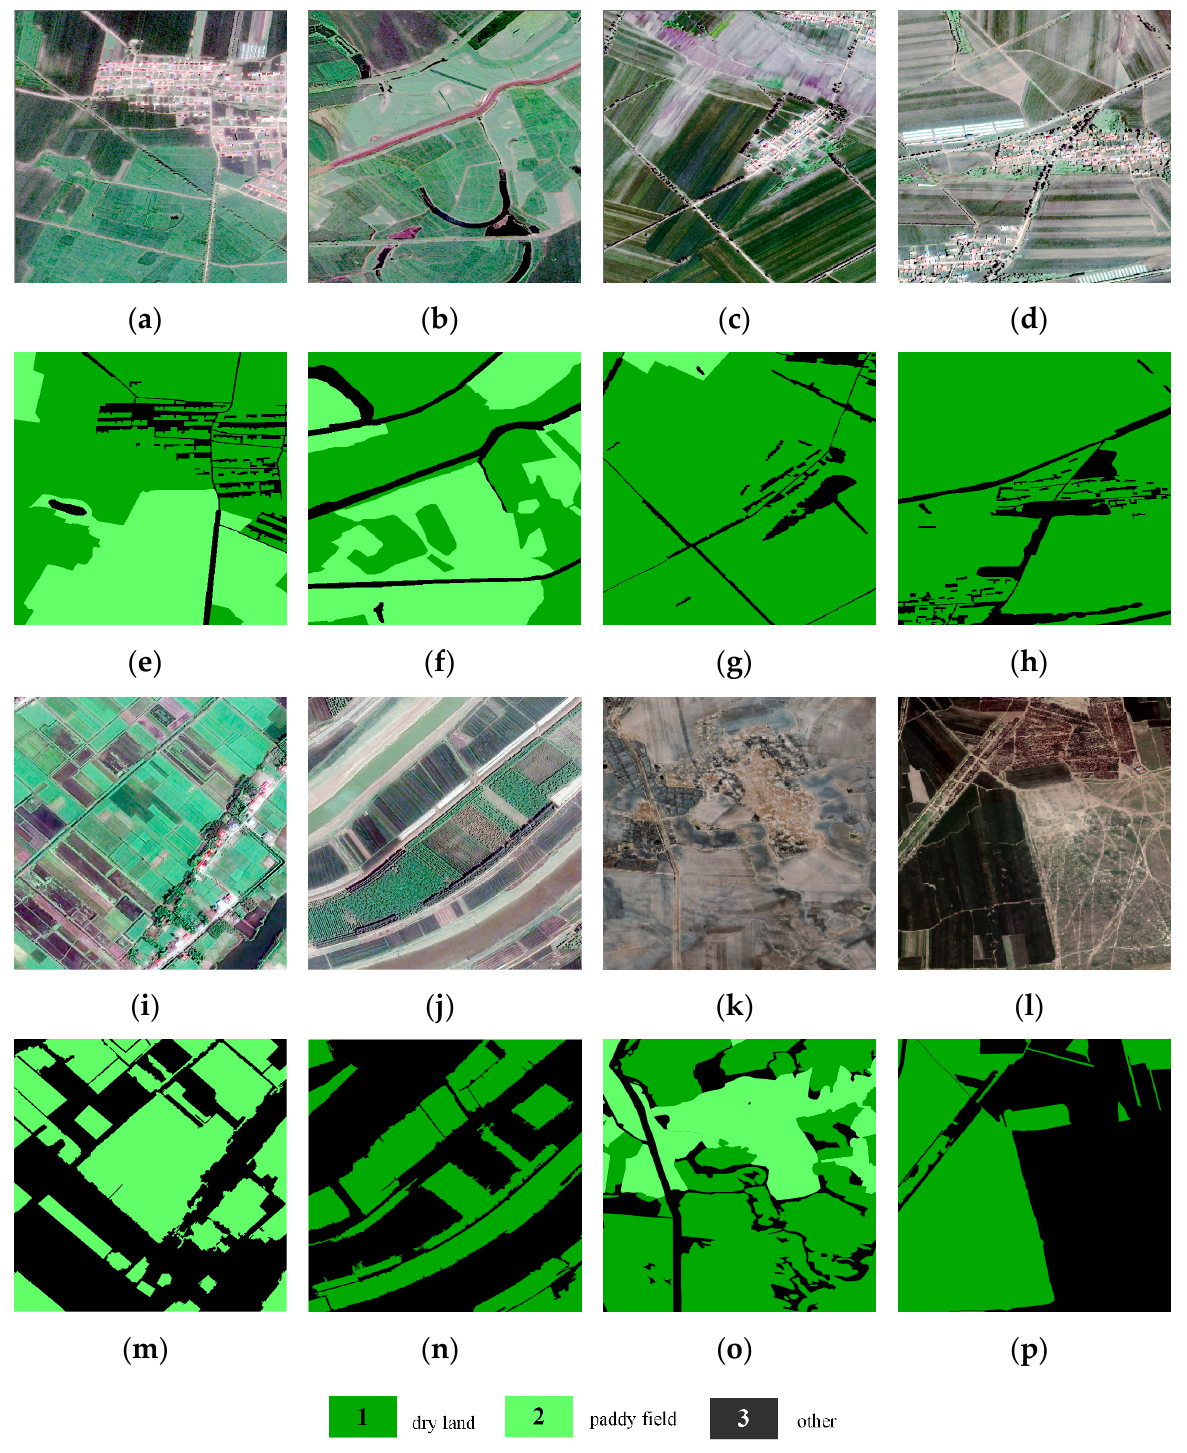
Figure 7. Jilin-1 high-resolution remote sensing cropland dataset: ( a – d ) and ( i – l ) are true-color remote Figure 7. Jilin ‐ 1 high ‐ resolution remote sensing cropland dataset: ( a – d ) and ( i – l ) are true ‐ color re ‐ sensing images, and ( e – h ) and ( m – p ) are their corresponding mote sensing images, and ( e – h ) and ( m – p ) are their corresponding labels.